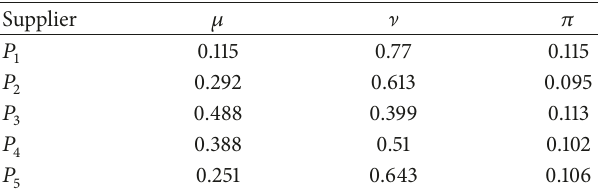
Table 7: 𝐶𝑥 𝑗 values.